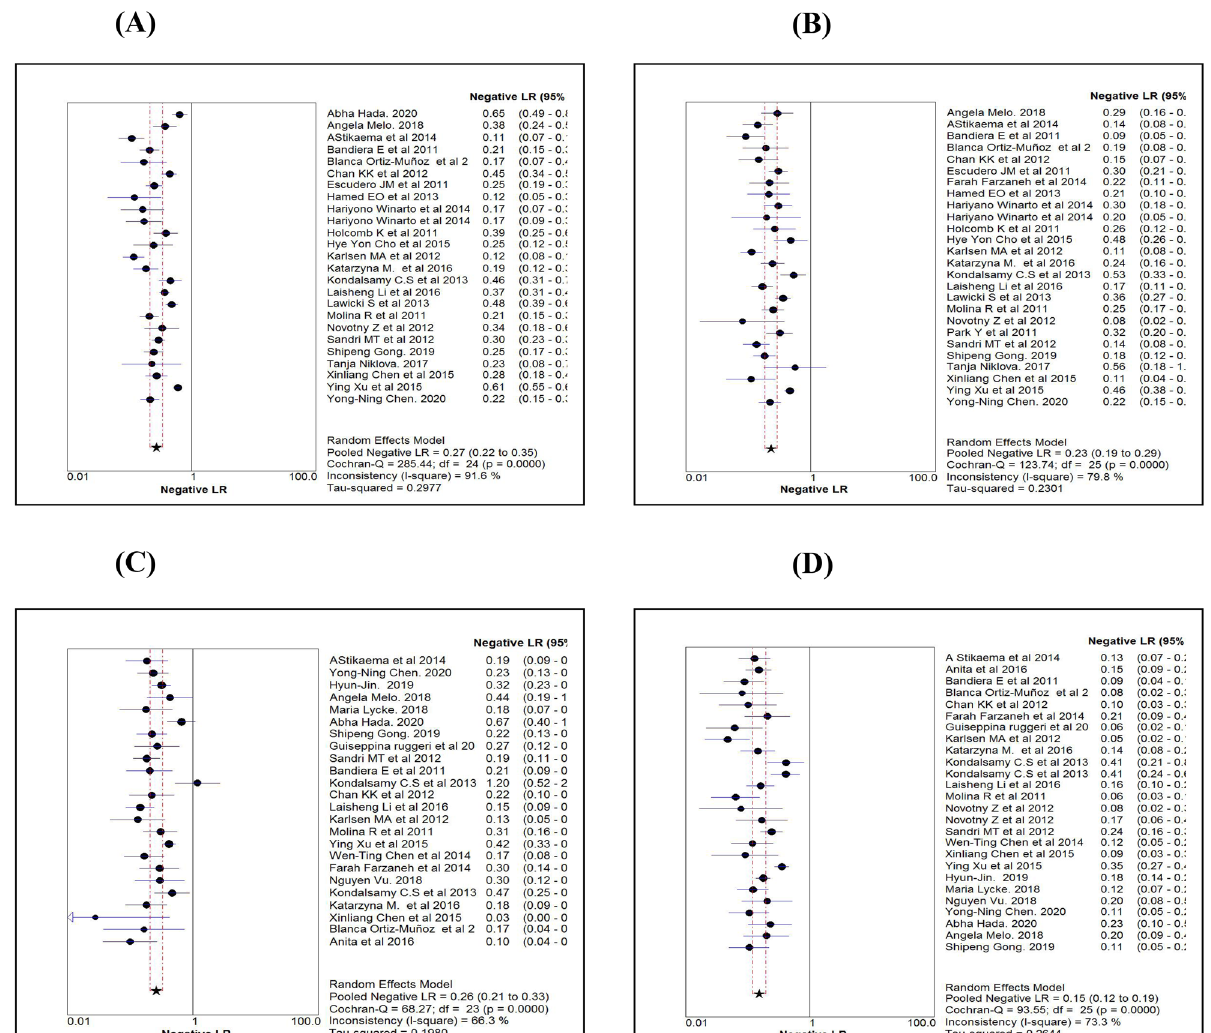
Figure 6. Comparison of negative likelihood ratio estimates (using Random effect model) of HE4 ( A ), CA125 ( B ), ROMA for pre-menopause ( C ) and ROMA for post-menopause ( D